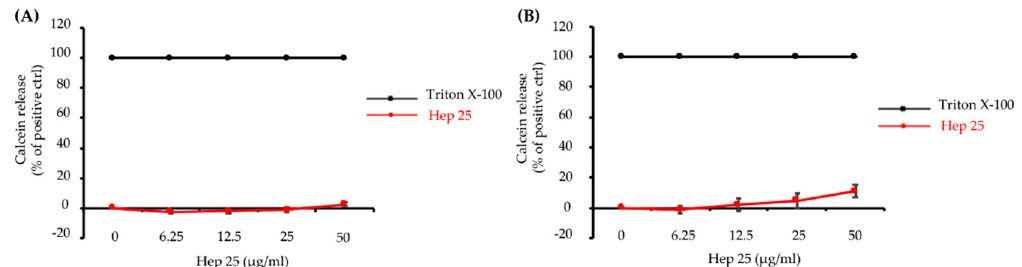
Figure 2. The effect of hep 25 on membrane integrity. Leakage of calcein from SUVs